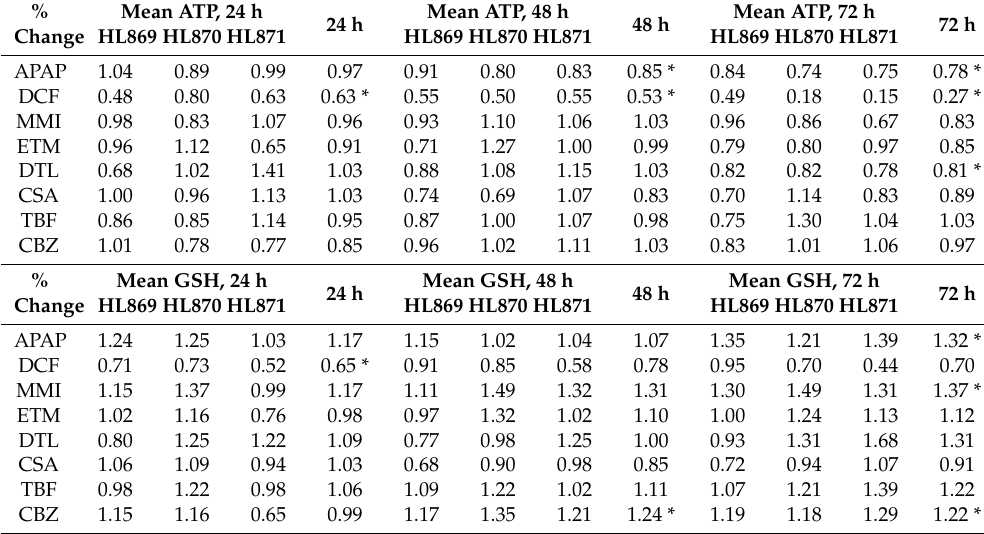
Table 2. Mean ATP and GSH values represented as a decimal from time-matched control human liver slices at 24, 48 and 72 h of culture in the presence of various drugs. Statistical significance (*) was determined using the Holm Sidak method of multiple t -tests with α = 5% (Prism, GraphPad 6.0). Mean ATP, 24 h 24 h % Change HL869 HL870 HL871